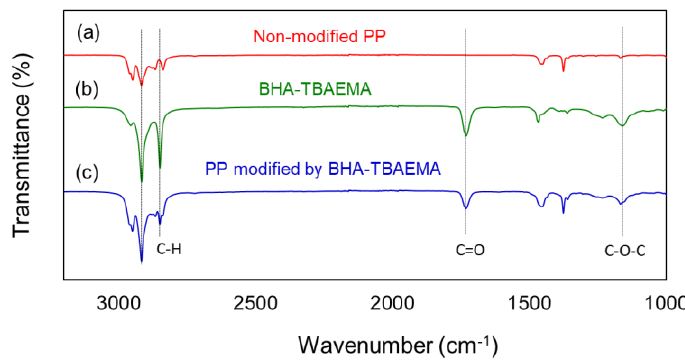
Figure 8. FTIR spectra: ( a ) non-modified PP; ( b ) BHA-TBAEMA; ( c ) PP modified with BHA-TBAEMA.